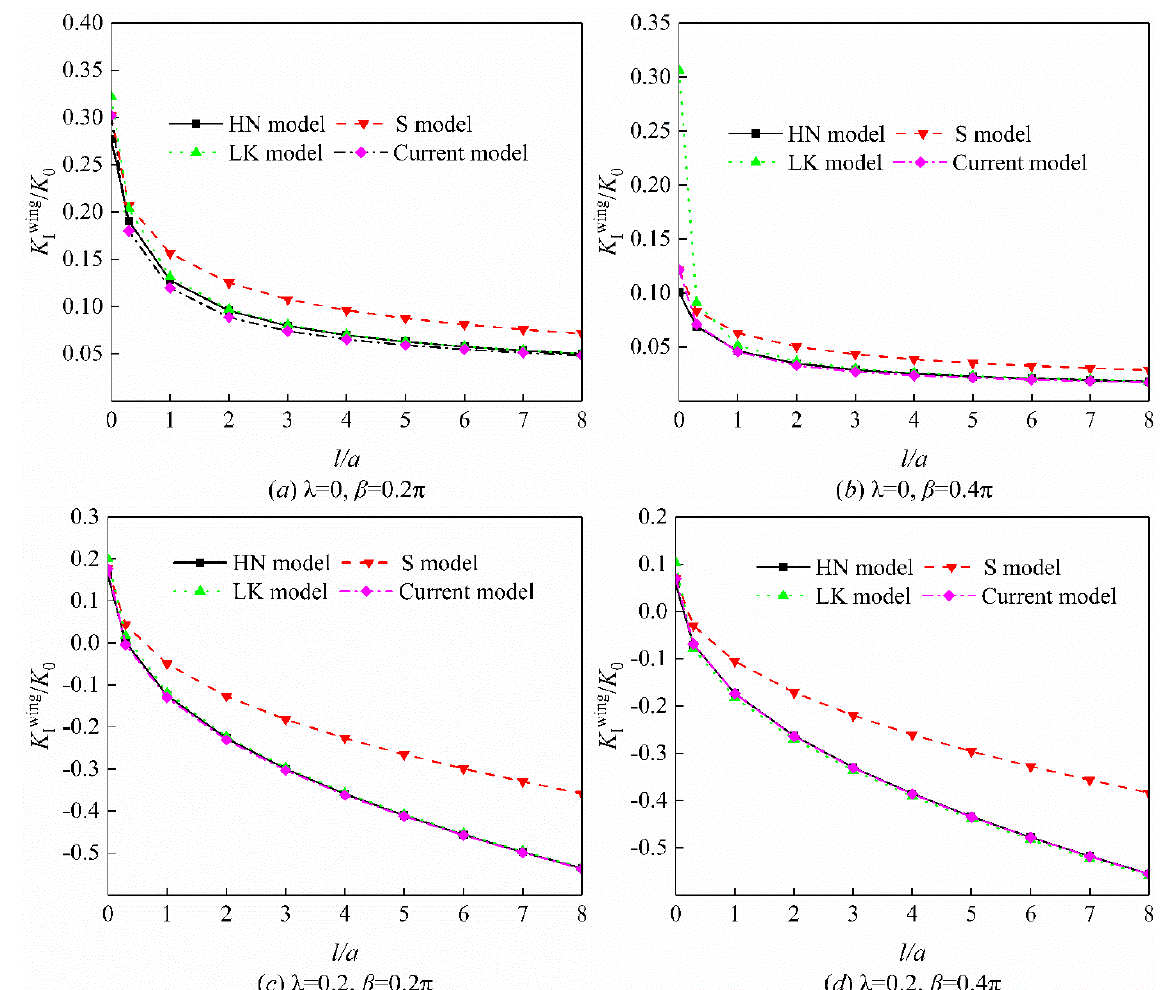
Figure 5. Relationships between dimensionless stress intensity factor and equivalent crack propagation length: ( a ) λ =0, β =0.2 π ; ( b ) λ=0 , β =0.4π ; ( c ) λ=0.2 , β =0.2π ; ( d ) λ=0.2 , β =0.4π .